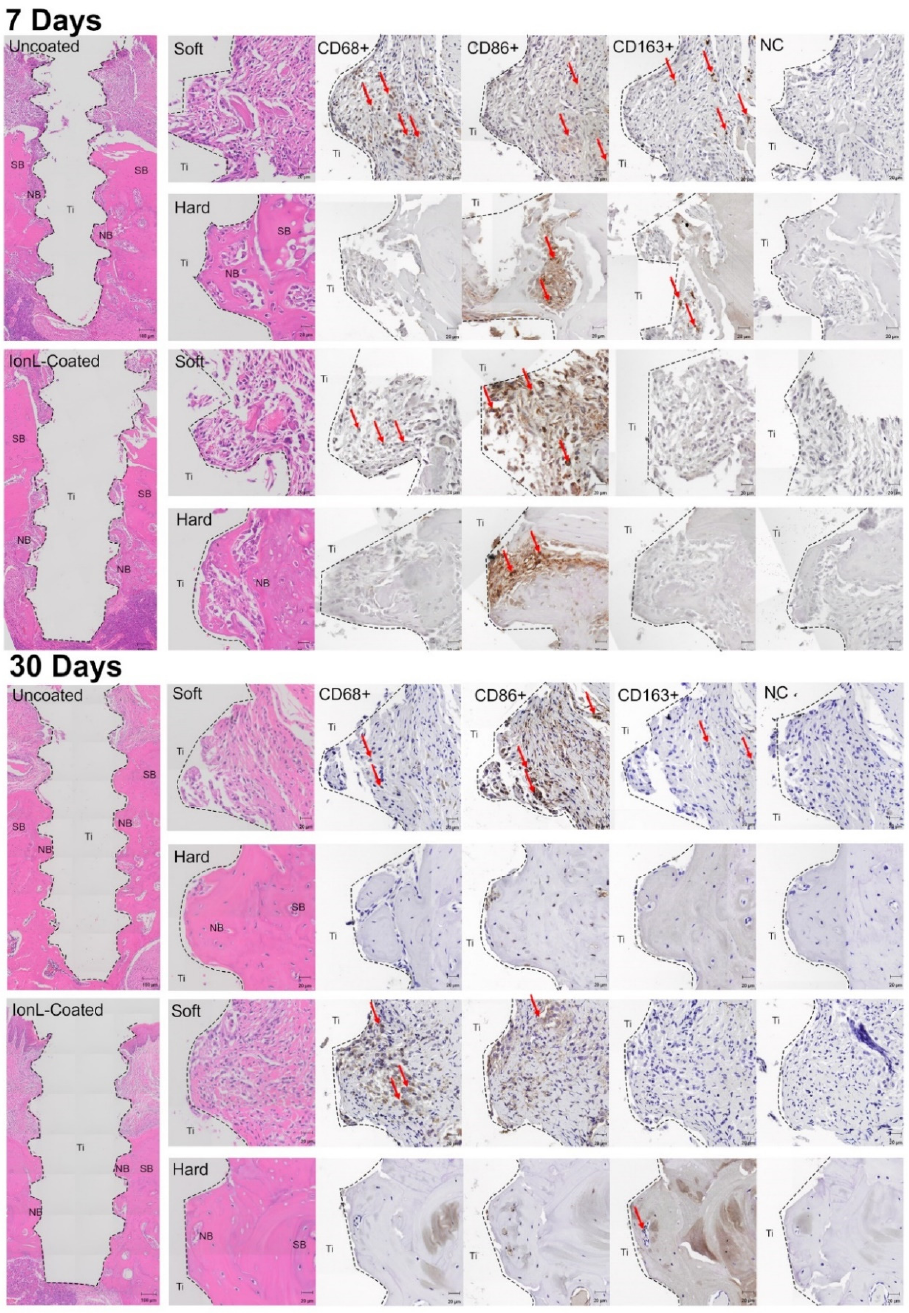
Figure 3. Histology representing peri-implant healing of uncoated and IonL-Phe-coated titanium over 7 and 30 days, H&E, and immunohistochemistry (IHC) for macrophages (CD68, CD163, CD86). Panel displays an overview of peri-implant tissue and a more detailed view of hard and soft tissue, respectively, from the same sample is all stains. NC is a negative control for IHC, SB is supporting bone, NB is new bone, and Ti is the void left by the implant after processing. Arrows indicate examples of positively stained cells for each marker.